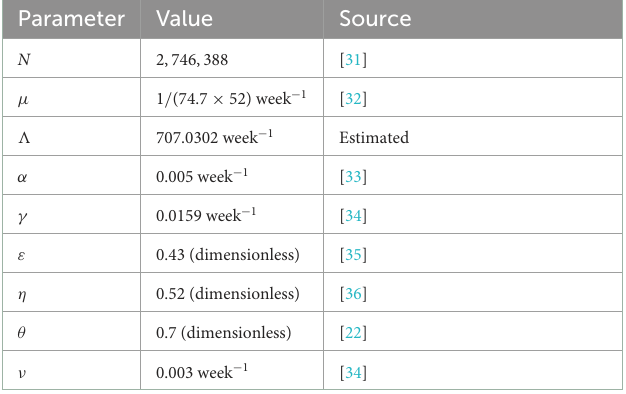
TABLE 3 Baseline values of the fixed parameters of the model (Equations 1–4).